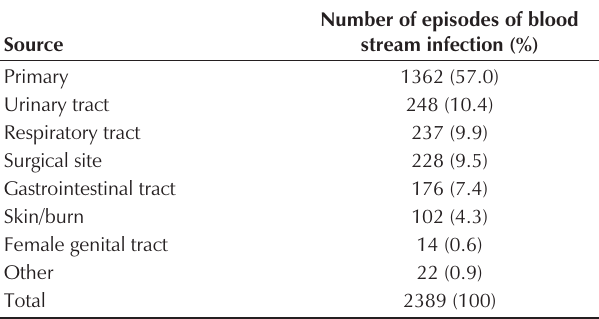
Sources of infection of nosocomial blood stream infection, University of Alberta Hospital, 1986 to